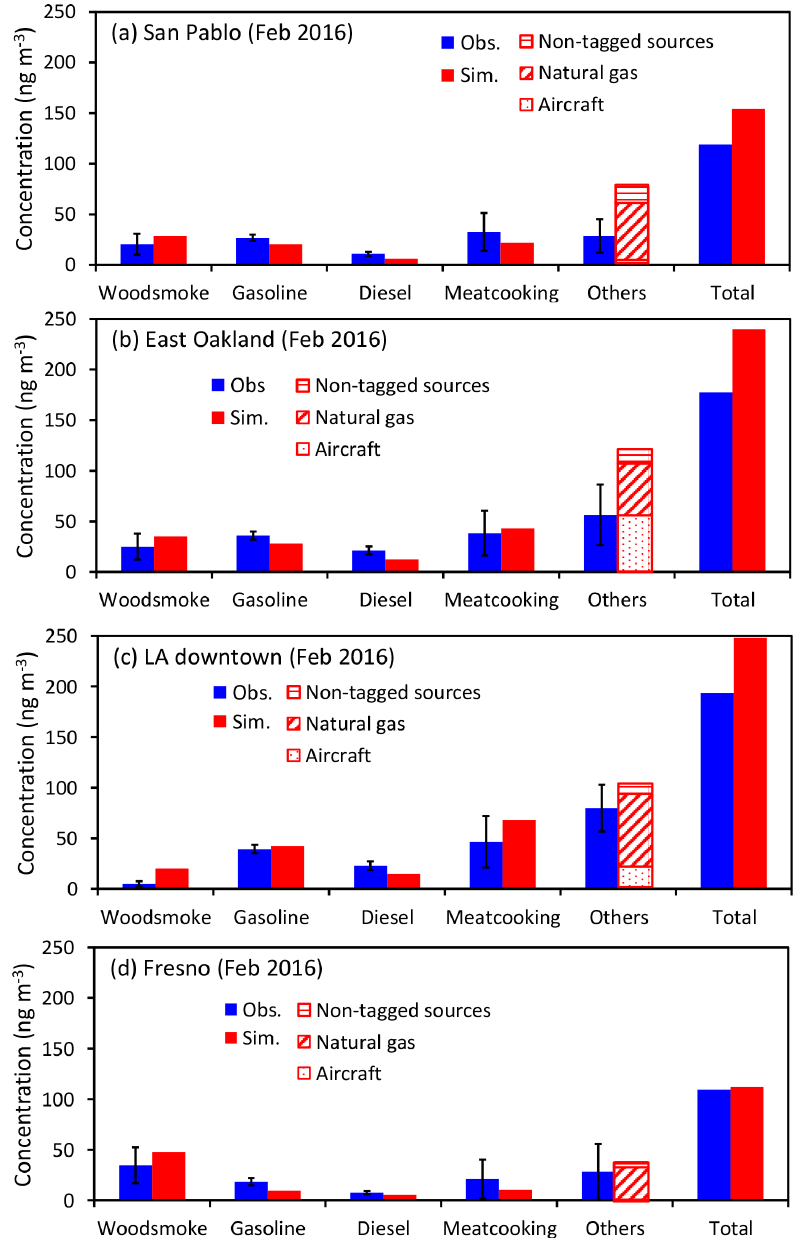
Figure 6. Source contribution to PM 0 . 1 predicted by the CMB receptor model and the UCD/CIT model at four sites in California in Febru- ary 2016. CMB results are calculated using 3d average measurements composited for a full